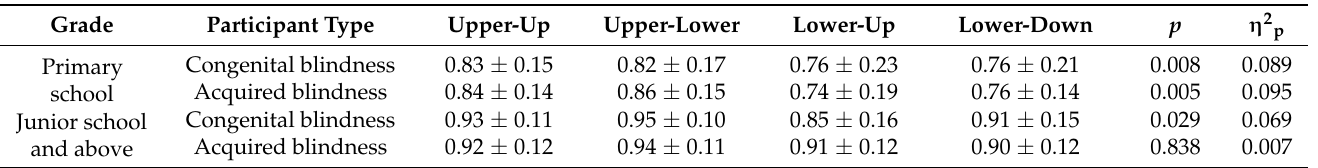
Table 2. Correct rate, significance and effect size of participants’ responses under different grades, participant types, and spatial location (M ±